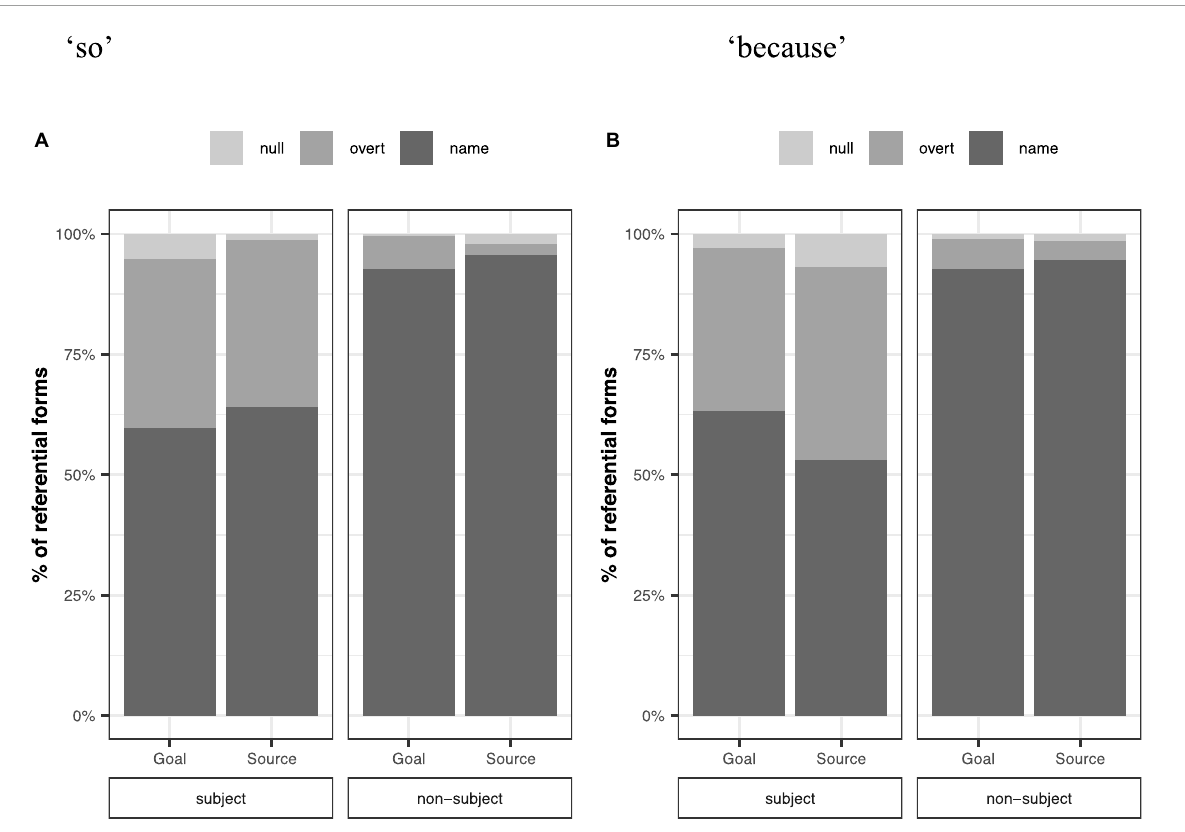
FIGURE2 Percentages of referential forms by grammatical role (subject vs. non-subject) and thematic role following “so” (A) and “because” (B) for transfer